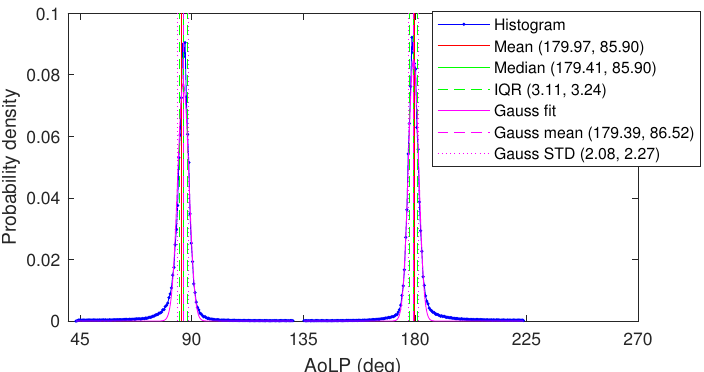
Figure 15. Histogram for the large ROI of Figure 14 in a similar format to the case of Figure 10.